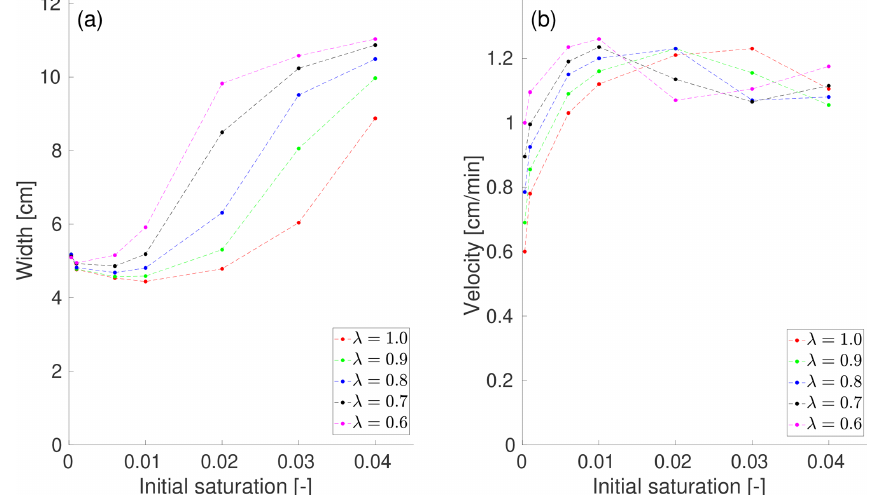
. The average of four different µ